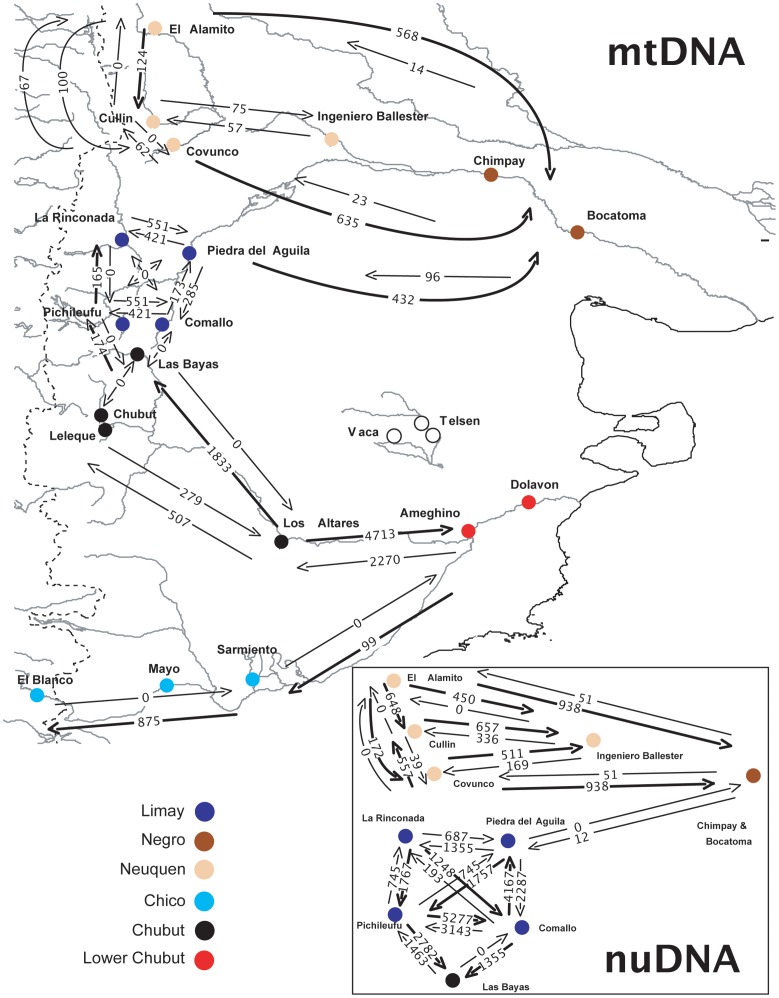
Gene flow estimates for mtDNA and a combined nDNA analysis using MIGRATE [71].A thick arrow indicates gene flow that is at least two-times greater in one direction than the opposite direction. Color codes indicate the six major rivers.